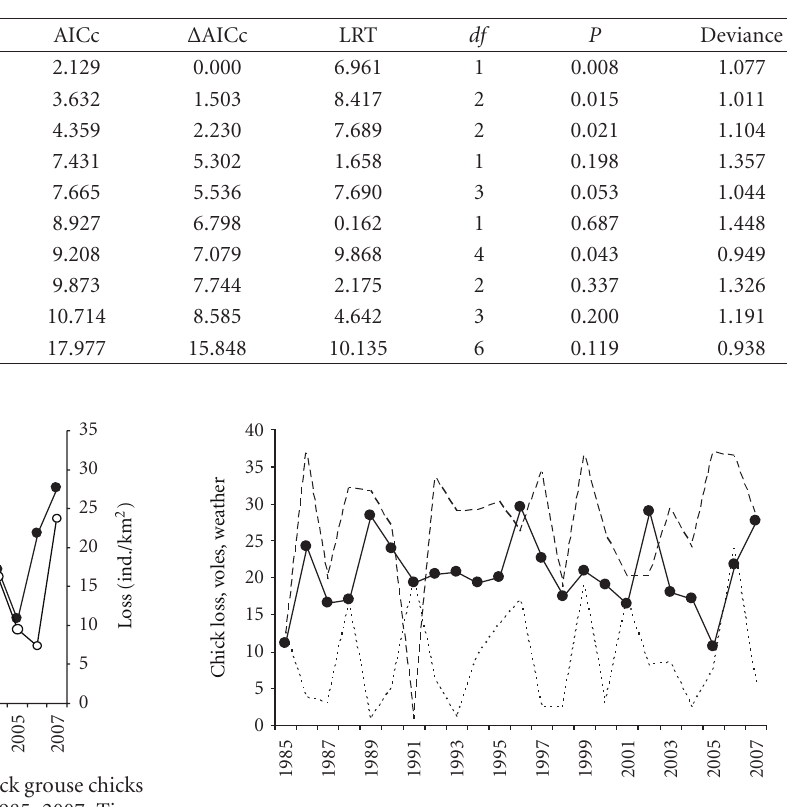
Figure 6: Losses of black grouse chicks ( • ), vole (dotted line) and weather indices (dashed line) in South Ostrobothnia and Oulu area during